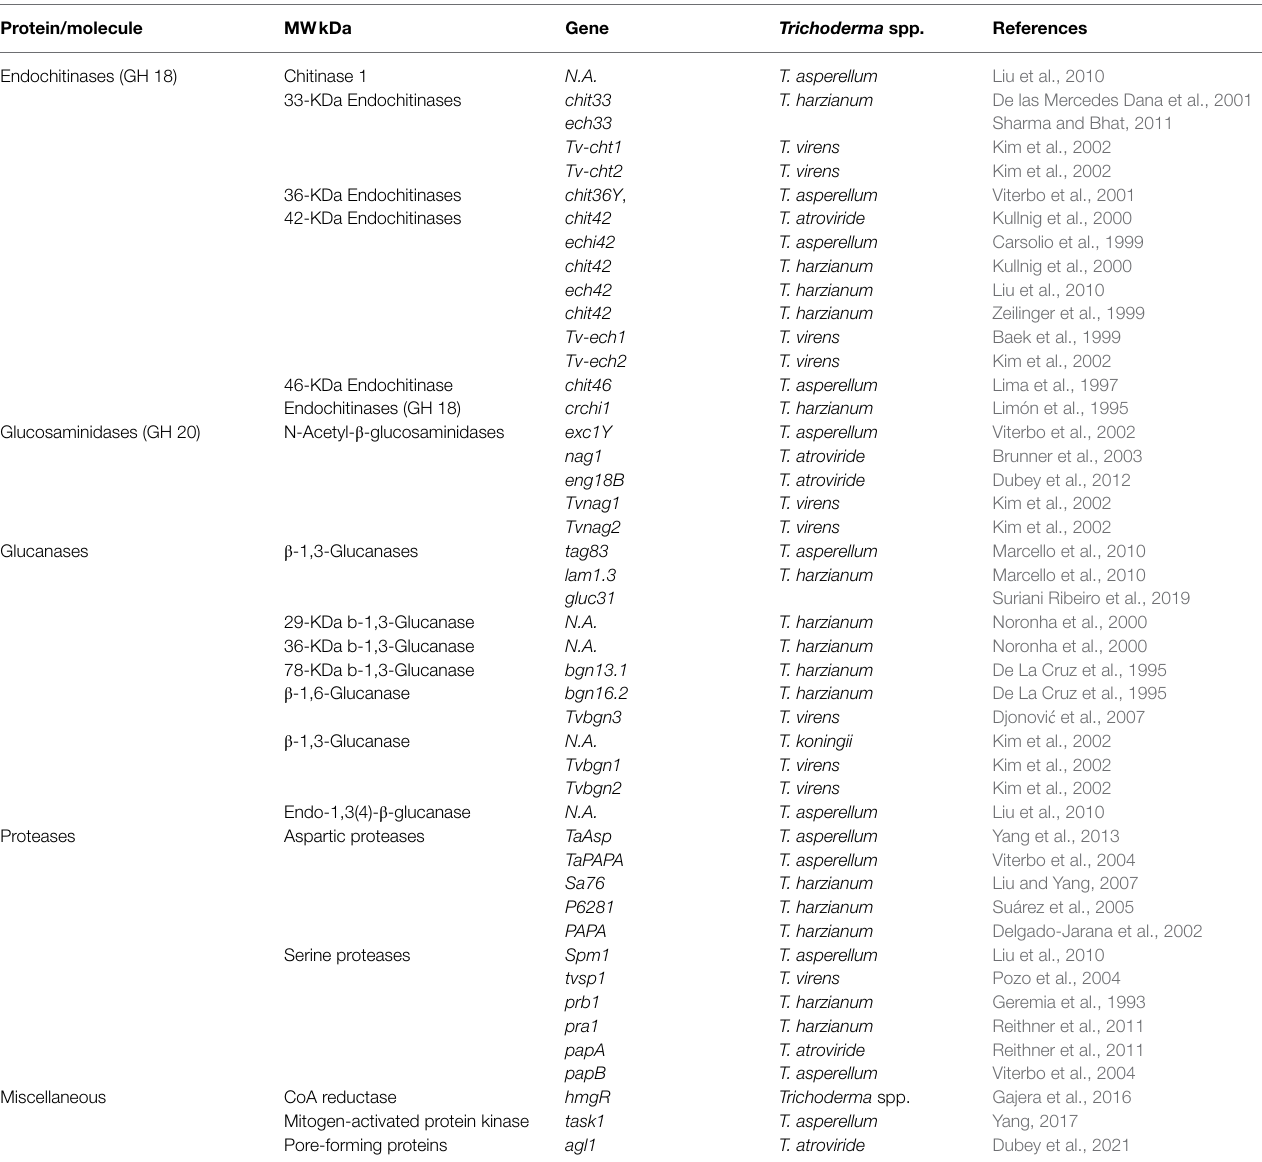
TABLE 2 | Role of Trichoderma spp. genes in the mycoparasitism of R. solani .